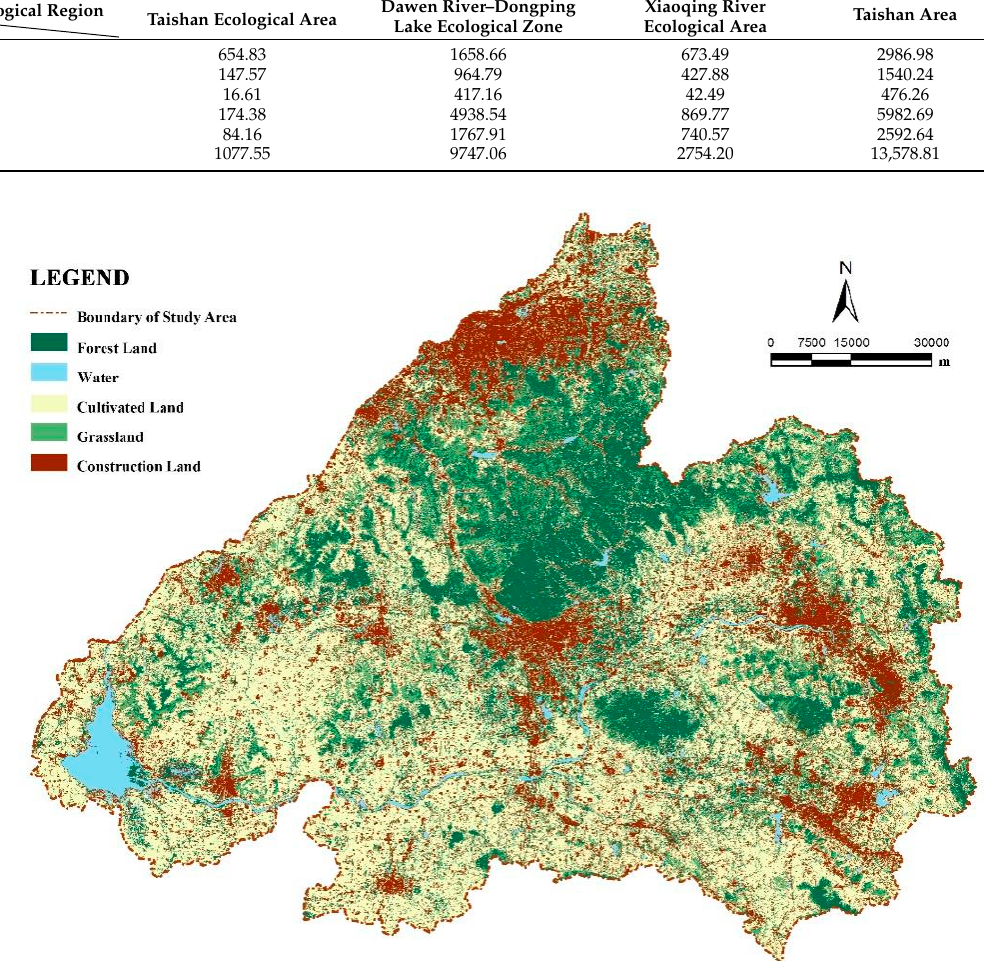
Figure 2. Land use status of the life community of mountains–rivers–forests–farmlands–lakes– grasslands in Taishan area. Table 2. Statistics of land use status of the life community of mountains–rivers–forests–farmlands– lakes–grasslands in Taishan